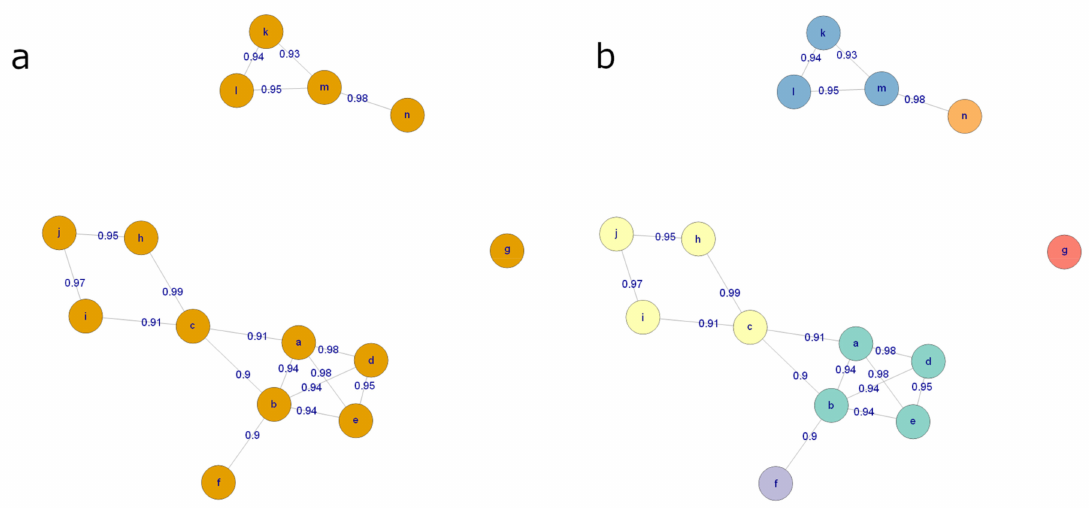
Figure 12. ( a ) An example graph, where every node is a molecular feature and every edge represents a high correlation coe ffi cient and a small retention time di ff erence between the features. ( b ) The graph after the clustering procedure. Each color corresponds to a distinct cluster of